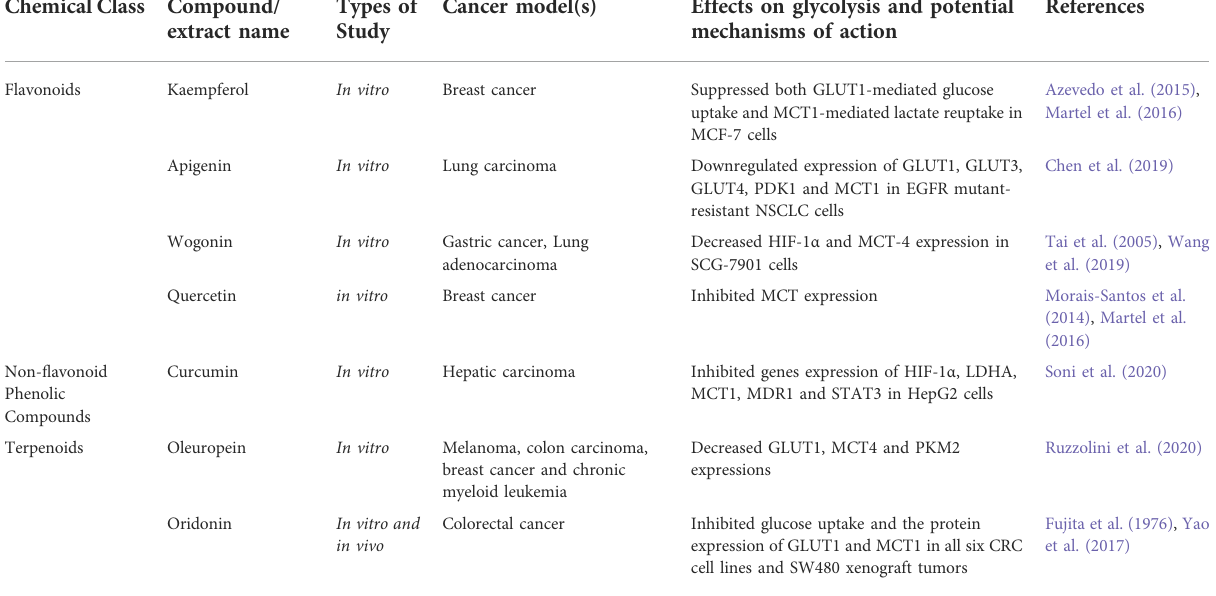
TABLE 7 Natural compounds target Monocarboxylic acid transporter